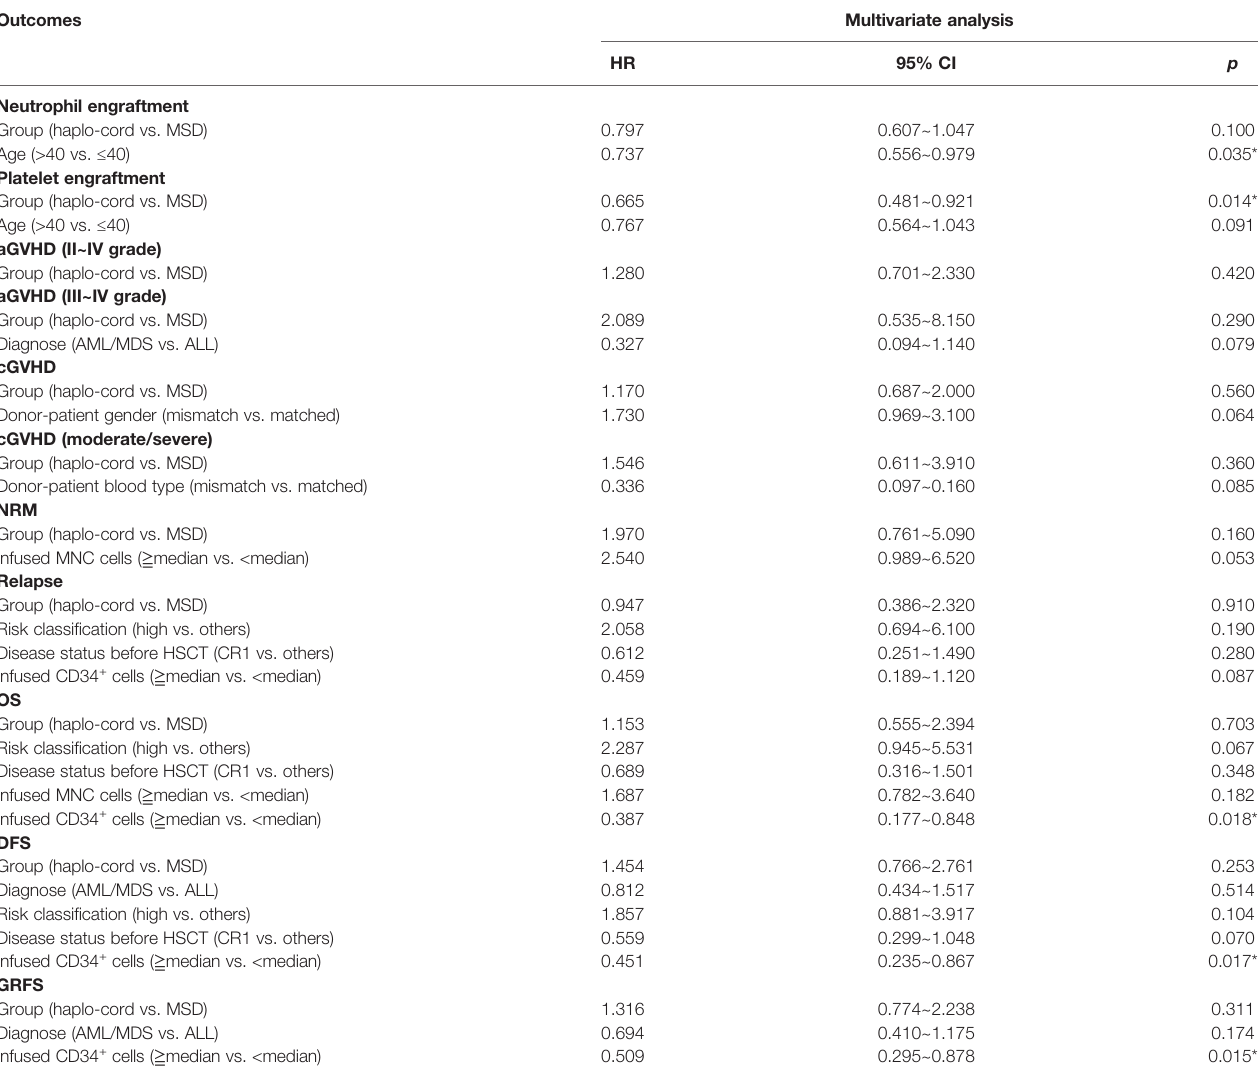
TABLE 2 | Multivariate analyses for transplant outcomes. Outcomes